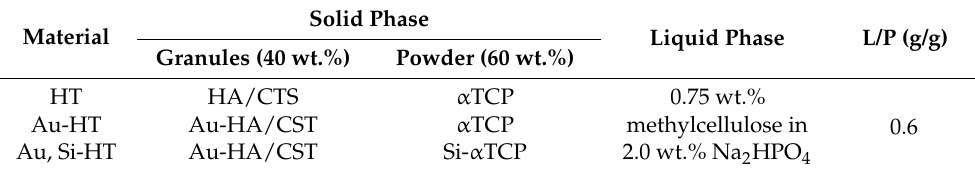
Table 1. Compositions of the studied